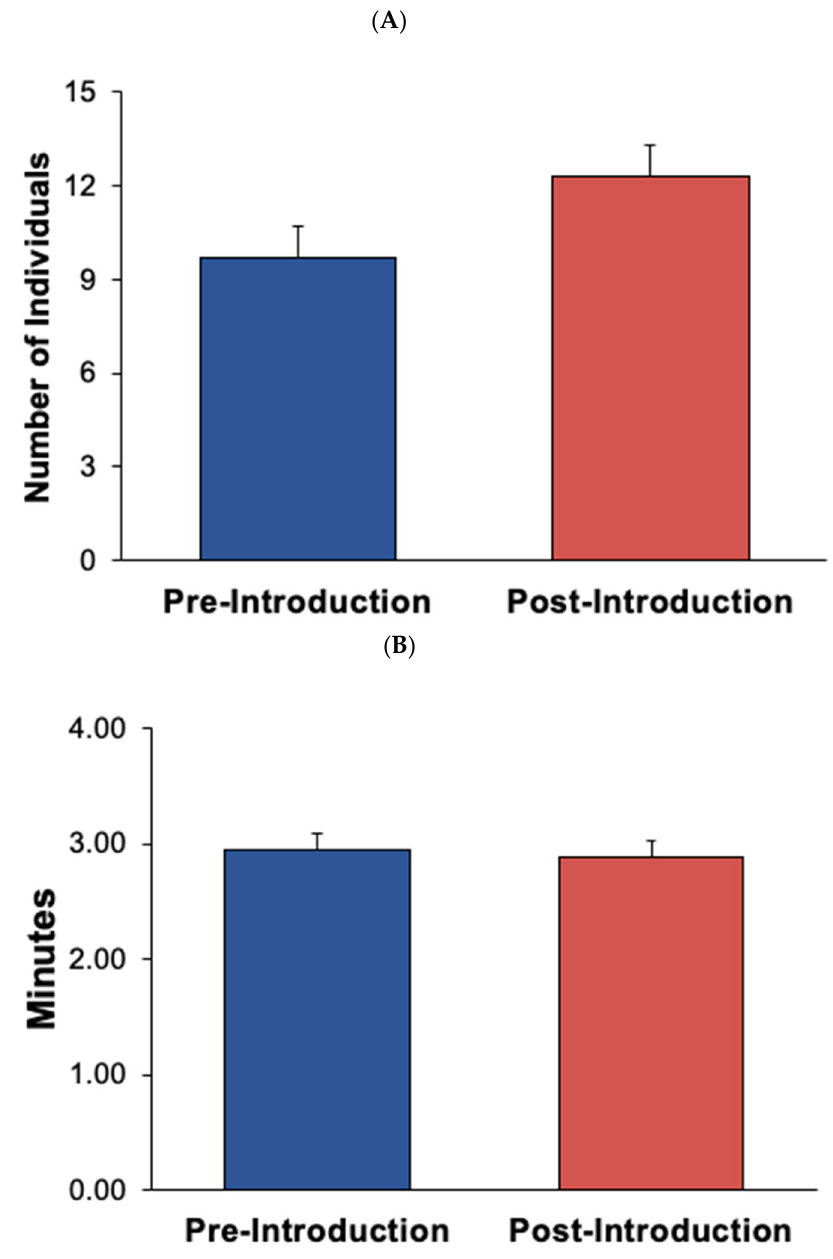
Figure 7. Visitor activity levels for Experiment 1, comparing pre ‐ and post ‐ introduction. ( A ) shows the mean number of individuals (visitor crowd size) in each condition, with standard error of the mean bars. ( B ) shows the average amount of time visitors spent at the exhibit in minutes (visitor length of stay) in each condition, with standard error of the mean bars.